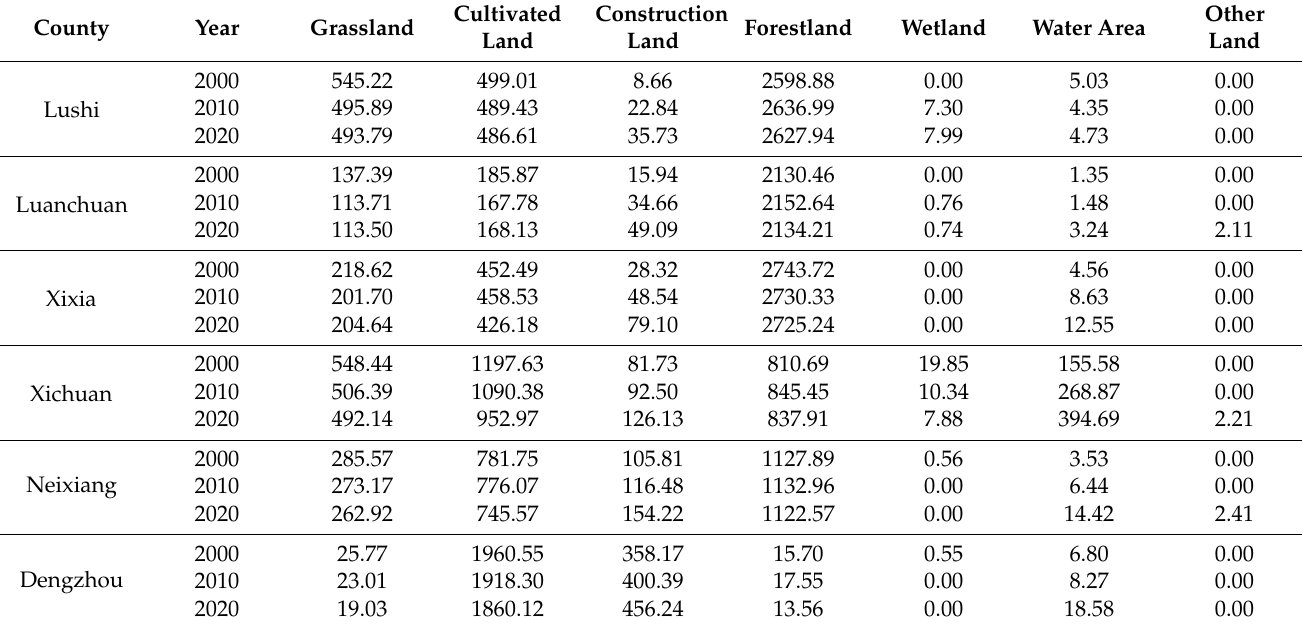
Table 5. Land use changes of each county (unit: km 2